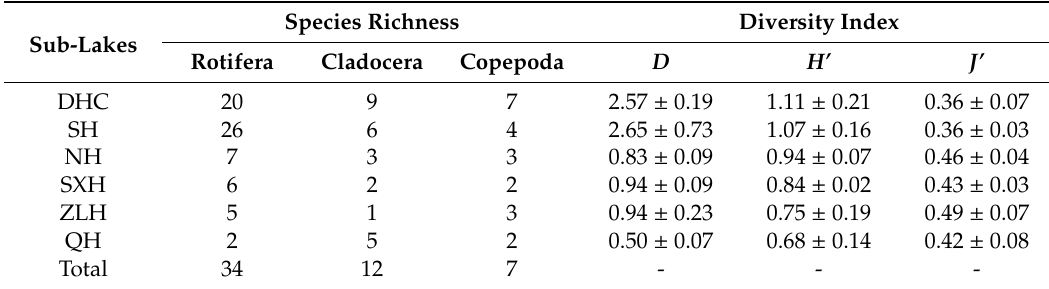
Table 3. Species richness and diversity index of zooplankton in six lakes. Species richness of Cladocera, Copepoda and Rotifera were count in DHC, SH, NH, SXH ZLH and QH. The diversity index including Margalef richness ( D ), Shannon–Wiener index ( H’ ) and Pielou’s evenness index ( J’ ) were calculated with total number of zooplankton and number of zooplankton species. Mean ± SE. Sub-Lakes